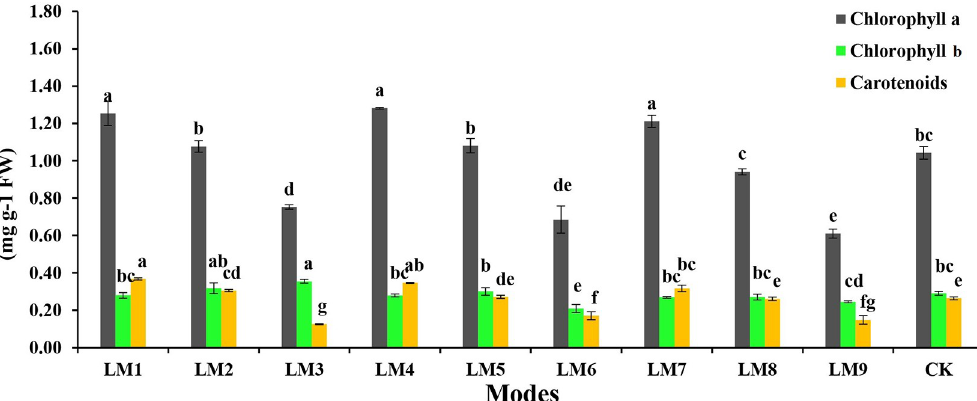
Fig 4. Effects of different lighting modes (LM) on chlorophyll a , chlorophyll b , and carotenoid content in leaves of E . Sativa plants. Values are means of four replicates ± SE. Different letters between columns indicate significant differences according to Duncan’s multiple range test at P � 0.05. LM1 = A1:B1:C1, LM2 = A1:B2:C2, LM3 = A1:B3:C3, LM4 = A2:B1: C2, LM5 = A2:B2:C3, LM6 = A2:B3:C1, LM7 = A3:B1:C3, LM8 = A3:B2:C1, LM9 = A3:B3:C1, CK = White fluorescent